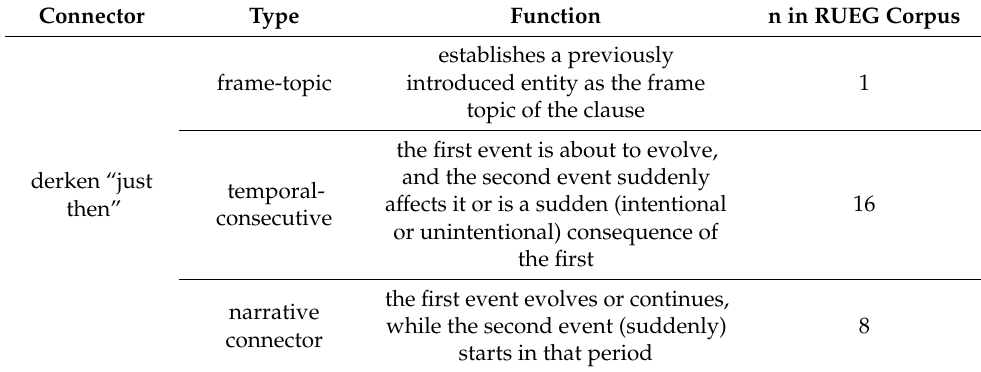
Table 6. Types and functions of derken in Turkish and uses in the RUEG corpus.